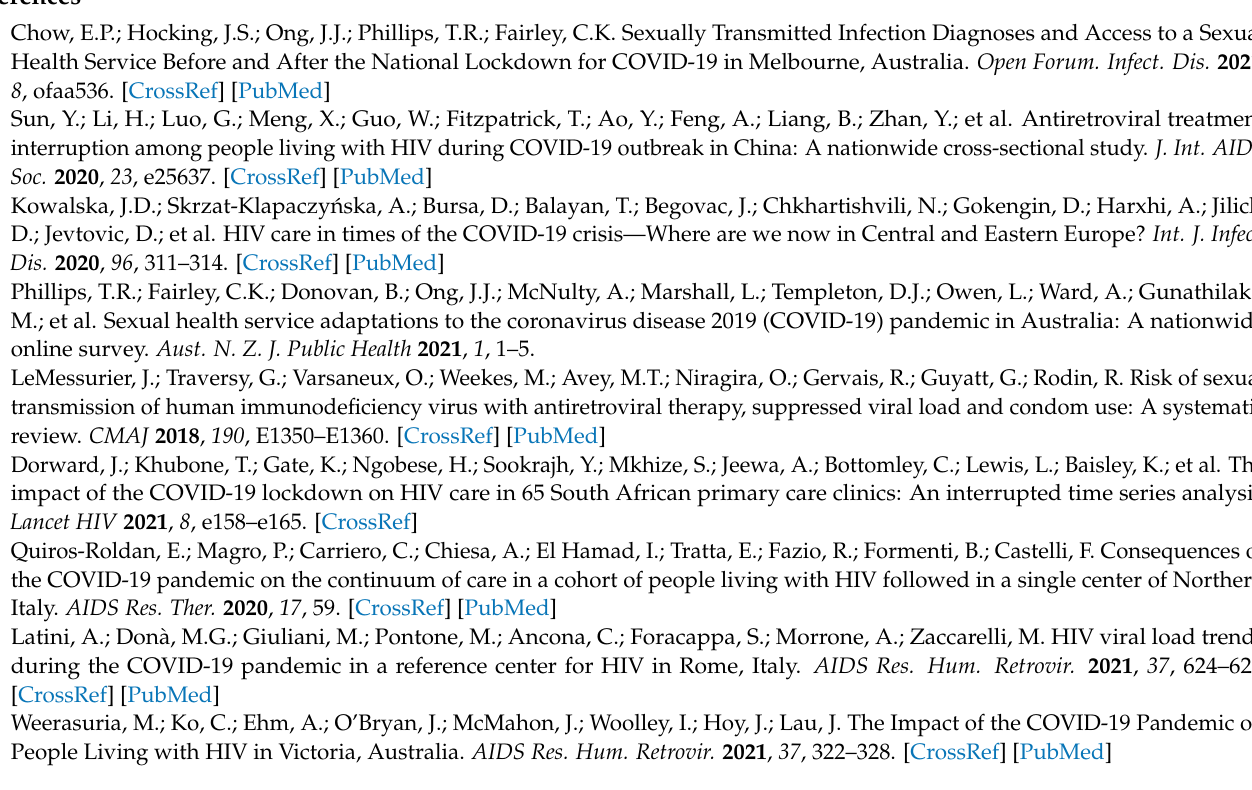
Table S1. Medication Possession Ratios (alternative approach), Table S2. Medication Possession Ratios for individuals with data for both 2019 and 2020 ( N =